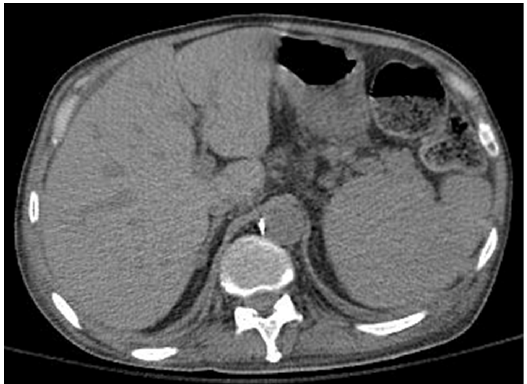
Figure 3. Computerized tomography of the liver shows steatosis with diffuse hepatocellular change. Throughout the hospitalization, the patient remained cytopenic, spiked fever, and eventually succumbed to respiratory failure and complications of prolonged